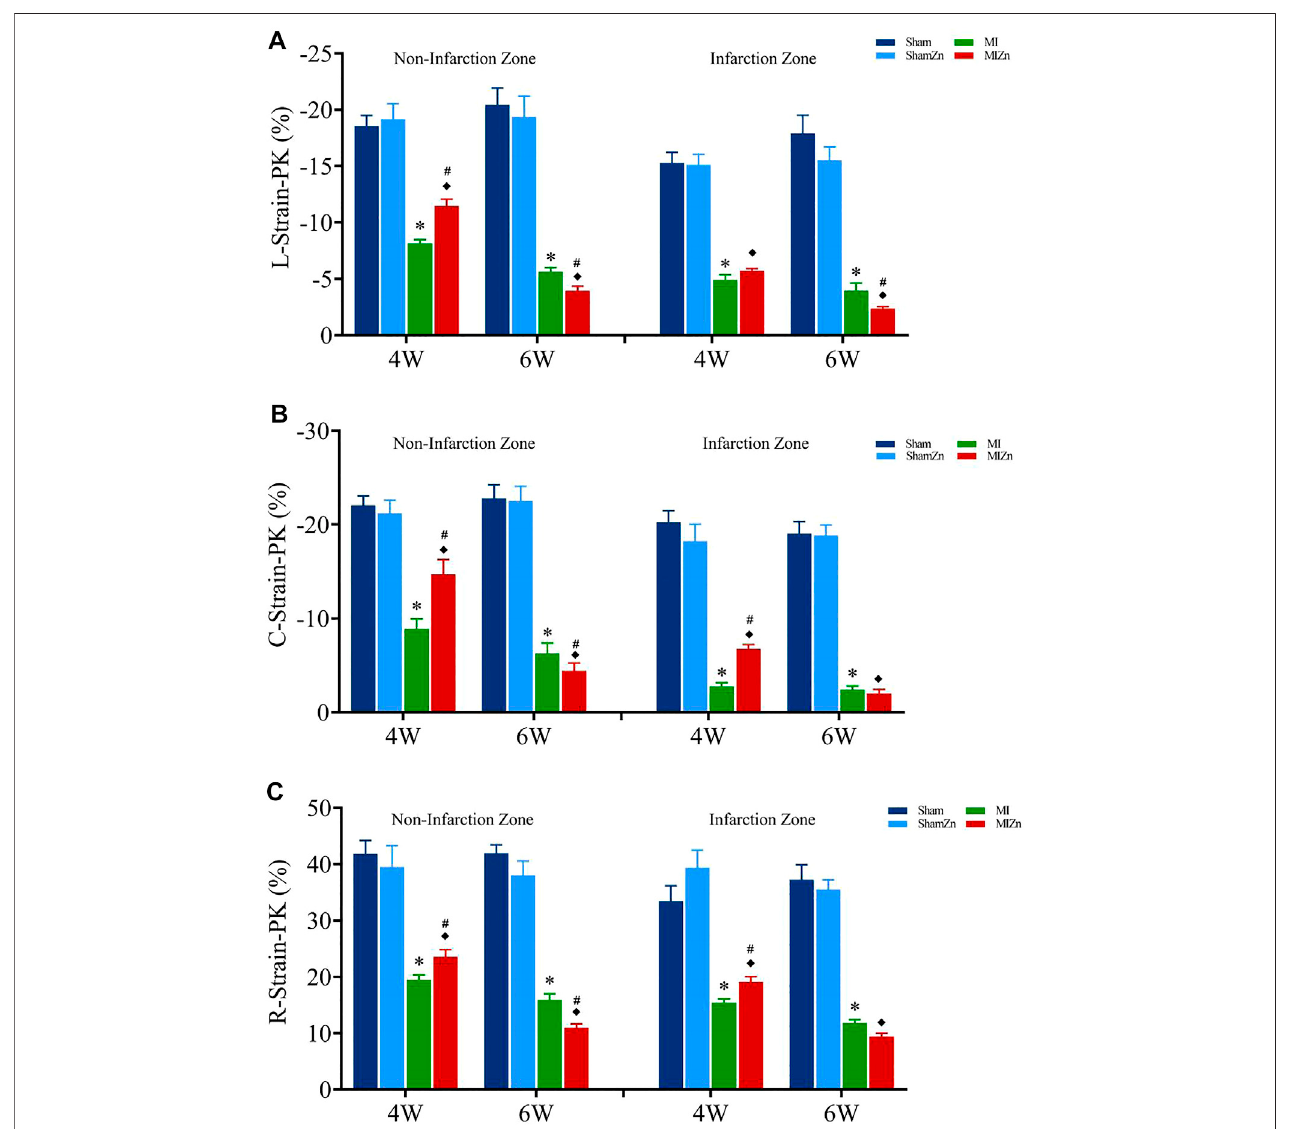
FIGURE 2 | Strain peak values in the longitudinal (A) , circumferential (B) and radial (C) directions of myocardial infarction zone and non-infarction zone in eight groups, L: Longitudinal, C: Circumferential, R: Radial. All of the data were shown as Mean ± SEM. * p < 0.05, MI vs. Sham; ◆ p < 0.05, ShamZn vs. MIZn; # p < 0.05, MIZn vs. MI.